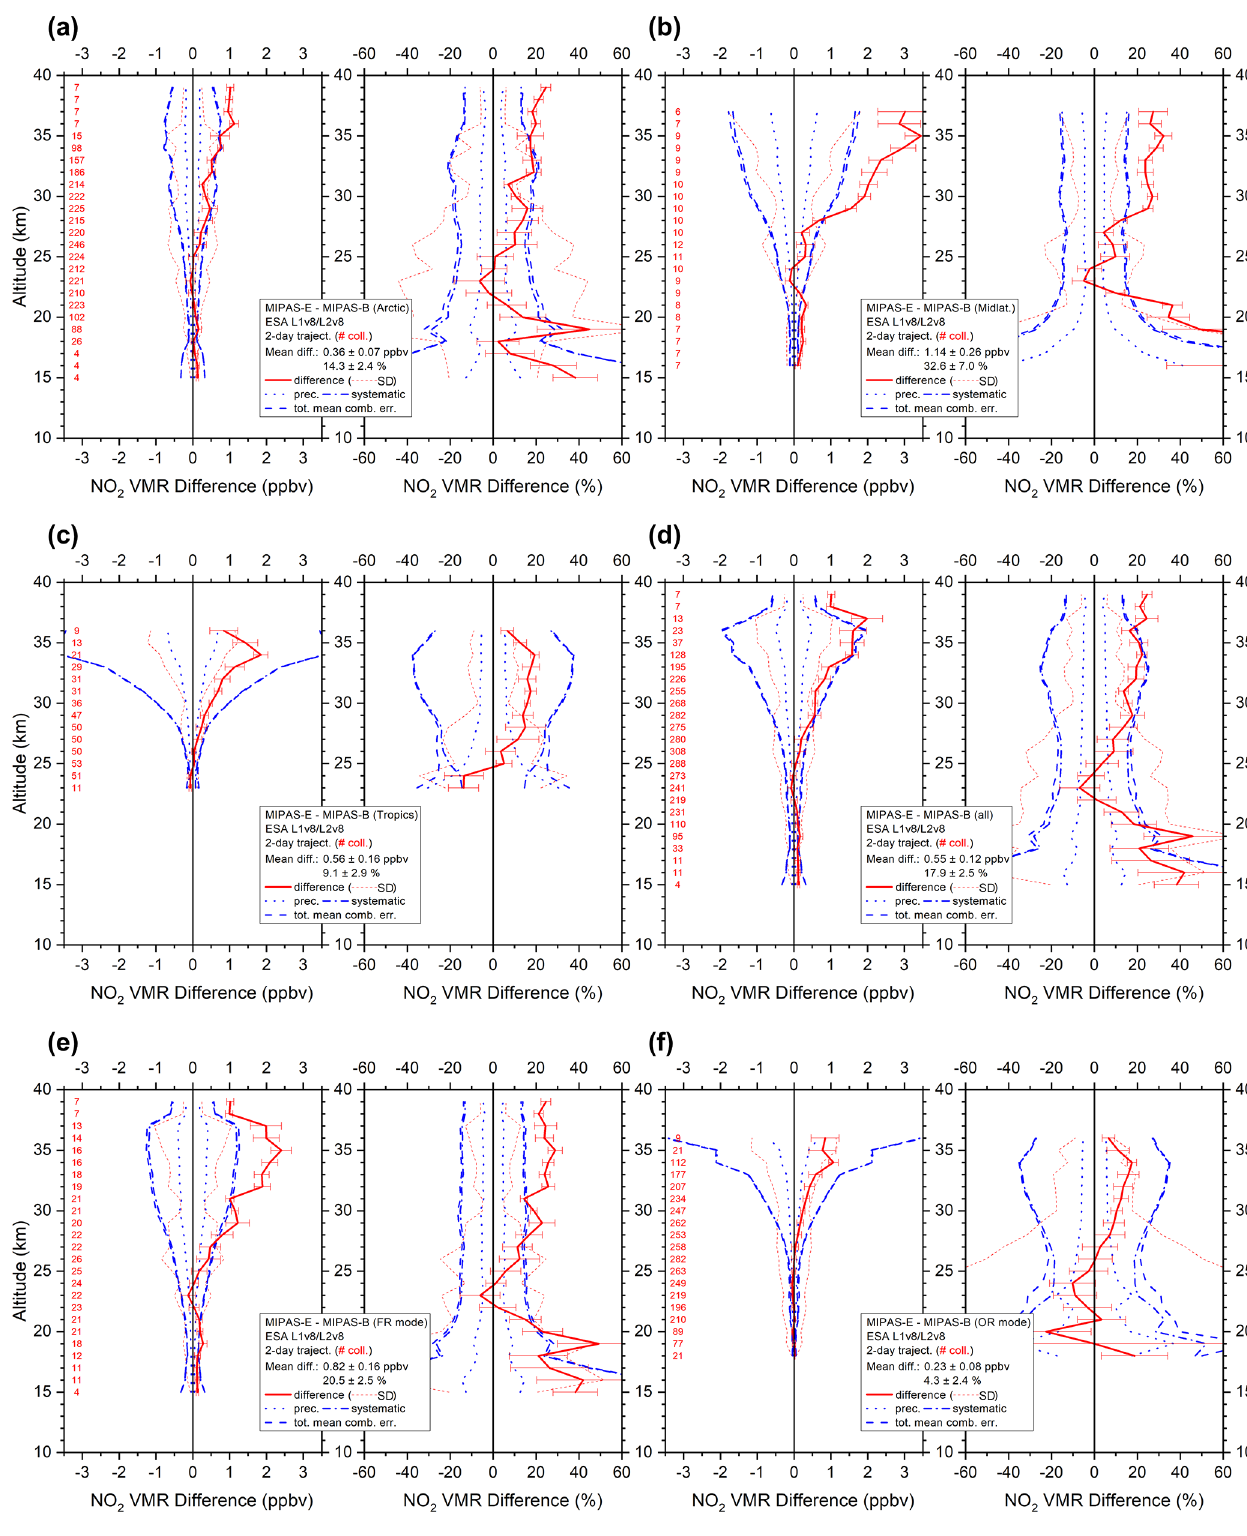
Figure 8. Same as Fig. 3 but for NO 2